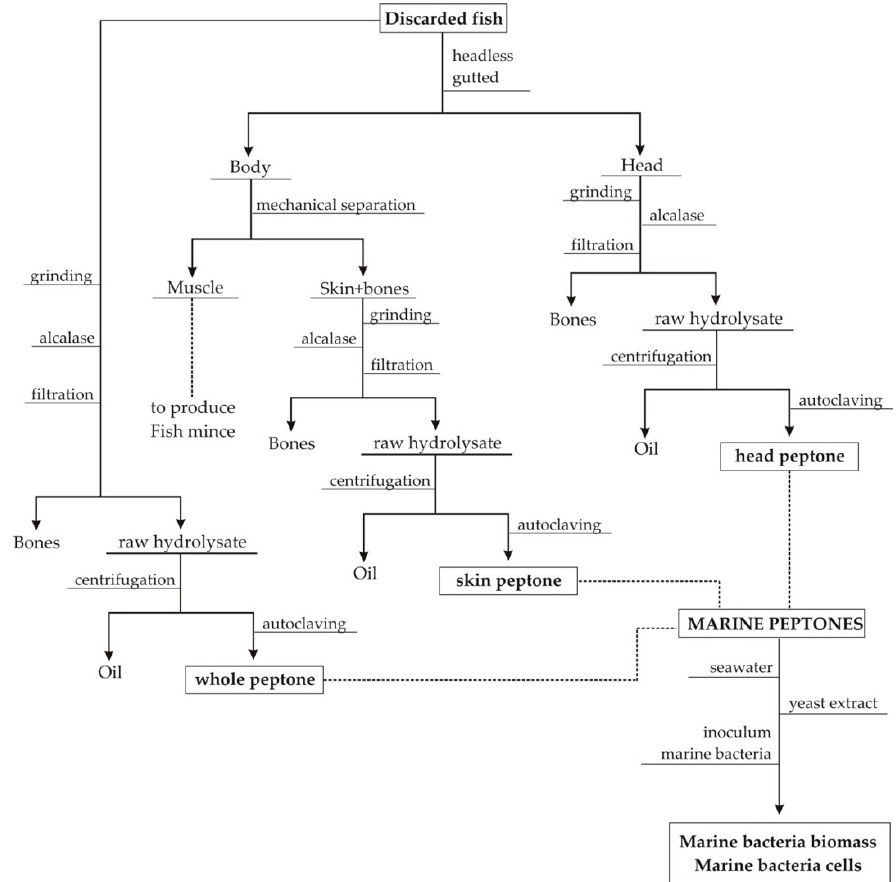
Figure 1. Flowchart of steps involved for the production of peptones from the skin, head, and whole individuals of discarded fish by fishing fleets.